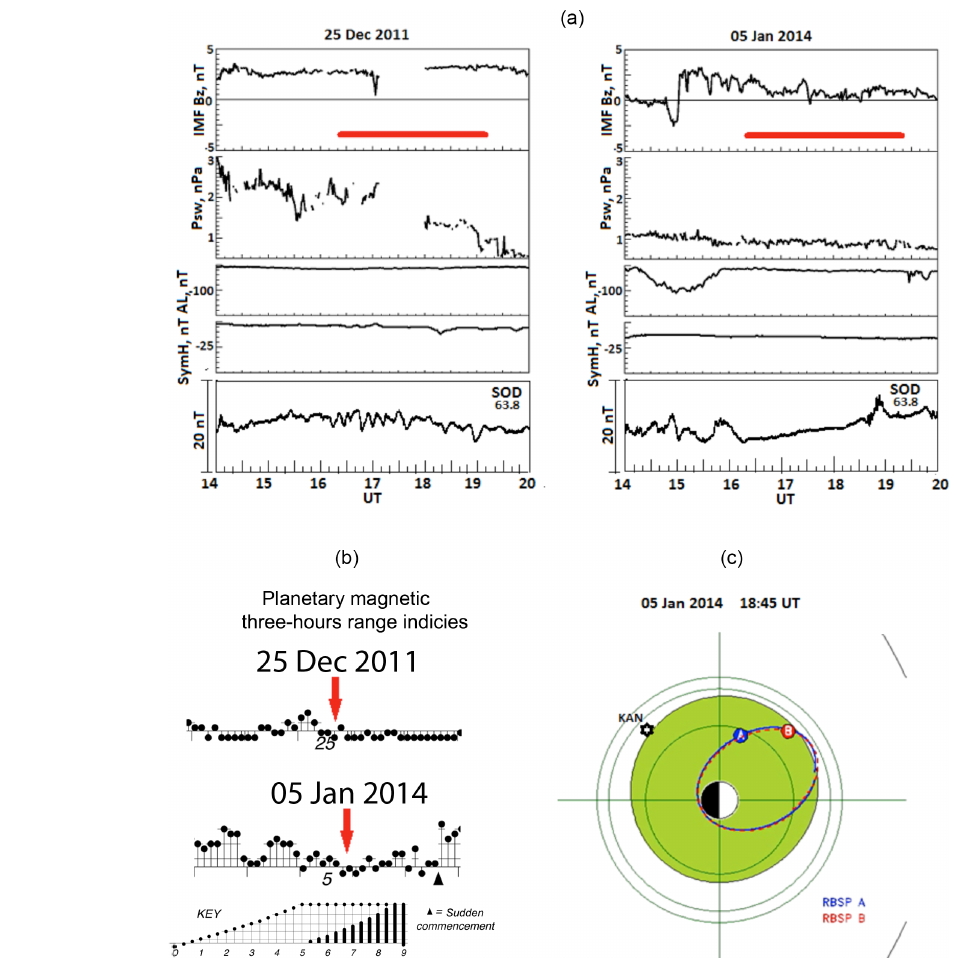
Figure 6. Geophysical situation during two considered events: (a) OMNI data (IMF Bz and Psw), the AL and SymH geomagnetic indexes, and the magnetograms from SOD; (b) the variation of the planetary Kp index; (c) the plasmapause location according to measurements on satellites RBSP (A and B) (available at: http://enarc.space.swri.edu/PTP; last access: 5 April